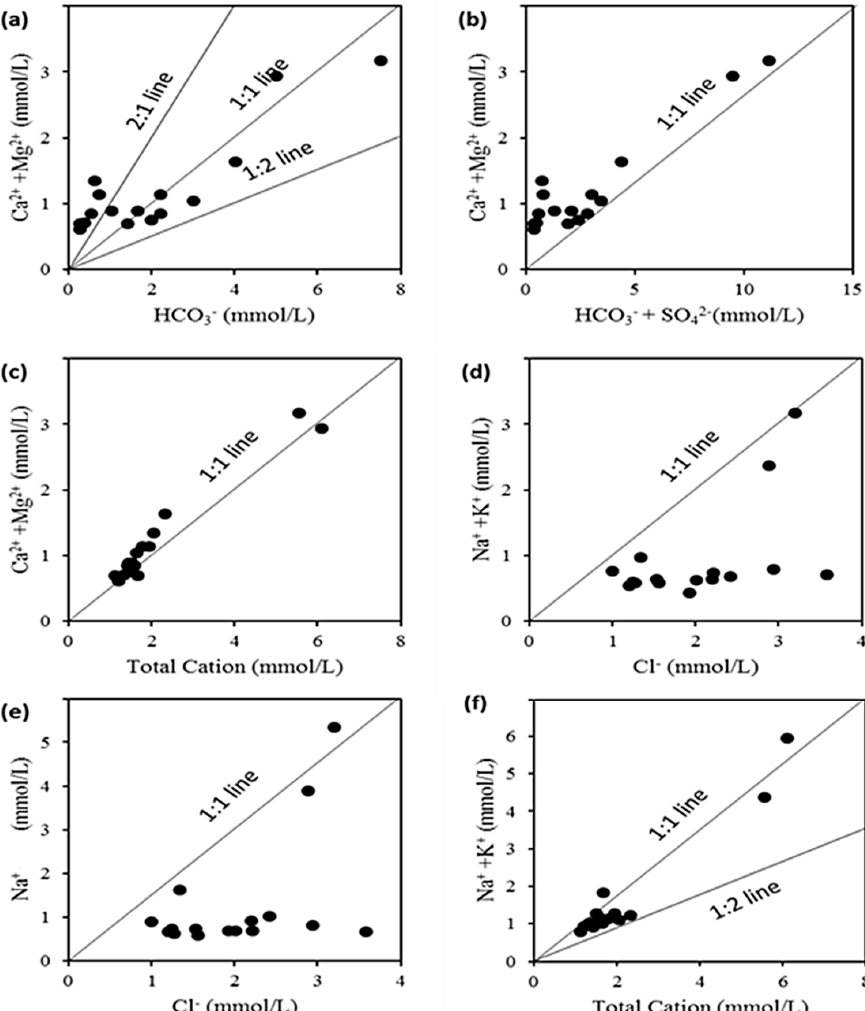
Figure 9. Bivariate plots of ( a ) HCO 3 − vs. Ca 2+ + Mg 2+ ; ( b ) HCO 3 − + SO 4 2 − vs. Ca 2+ + Mg 2+ ; ( c ) Total cations vs. Ca 2+ + Mg 2+ ; ( d ) Cl − vs. Na + + K + ; ( e ) Cl − vs. Na + ; ( f ) Na + + K + vs. total cation s.